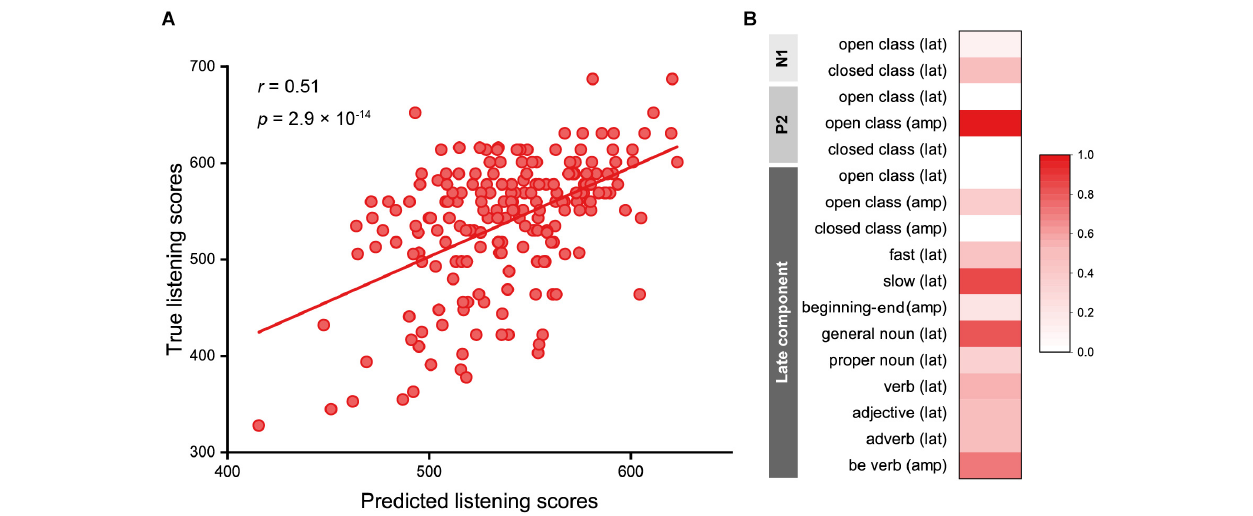
FIGURE 5 | Results of the predictive model for English proficiency based on EEG features. (A) The regression model predicted true listening scores, with a mean absolute difference between the true and predicted listening scores of 40.6 ± 36.1. The Pearson correlation coefficient was 0.51 ( p = 2.9 × 10 − 14 ). (B) Contributions of the EEG features shown in the range of 0 to